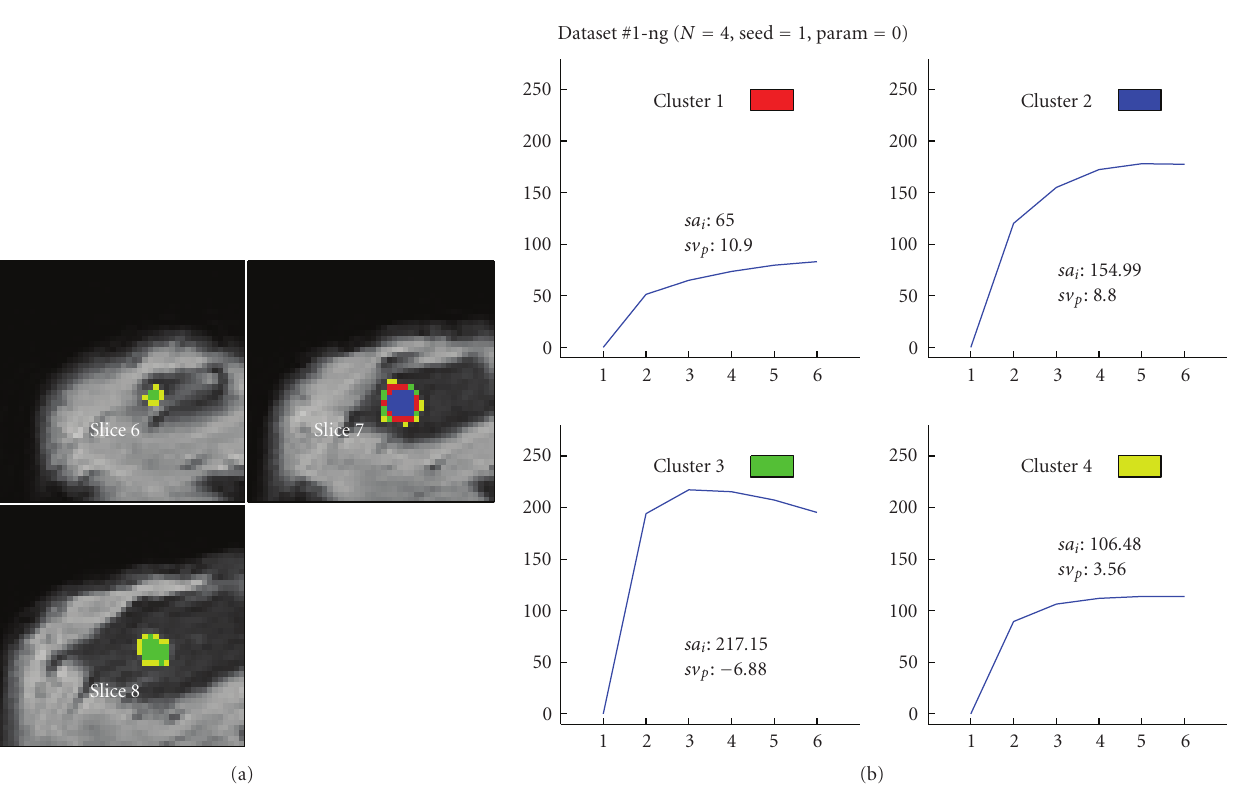
Figure 7: Segmentation method based on the “neural-gas” network applied to data set #1 (malignant lesion, DCIS) and resulting in four clusters. (a) shows the cluster distribution for each slice ranging from 6 to 8. (b) visualizes the representative time-signal intensity time curves for each